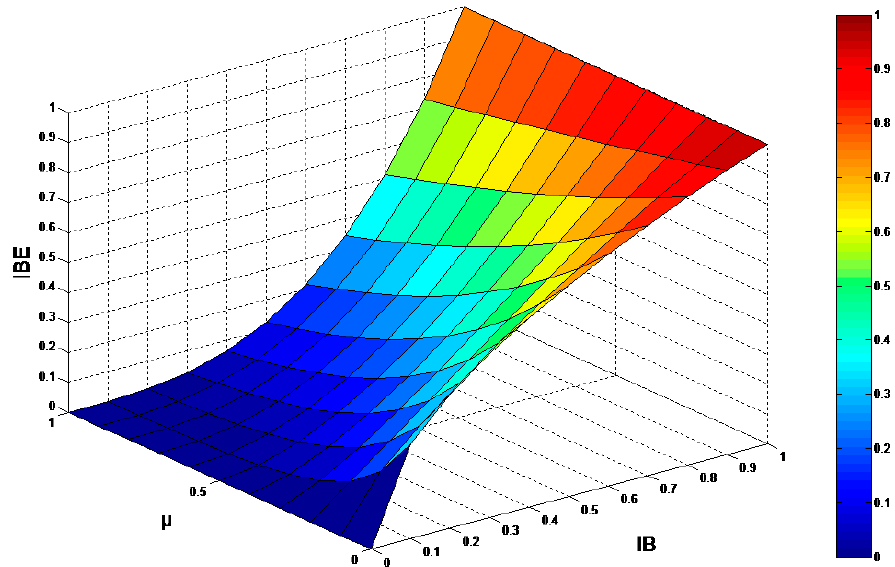
Figure 5. Diagram of Brightness Correction Function.